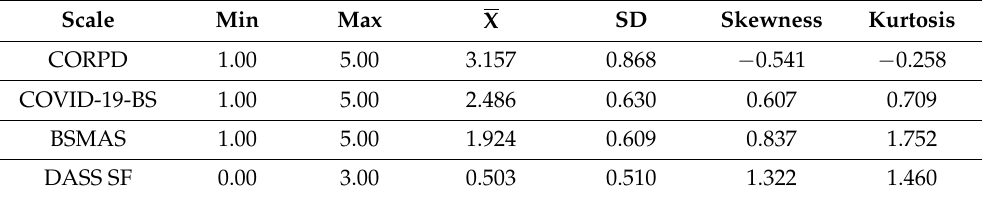
Table 3. Mean, standard deviation, skewness, and kurtosis values of the